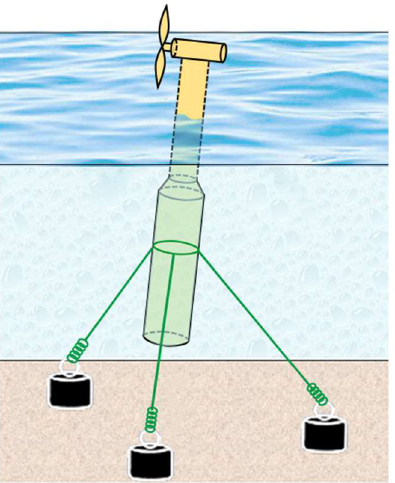
Figure 3. Spar-typed wind turbine with its taut mooring lines. The translational motion and the rotational motion of a rigid body are expressed in the spaced-fixed coordinate system OXYZ with origin at O and the body-fixed coordinate system oxyz with origin at o , respectively. Where ξ is the translational displacement of the body at point o in OXYZ , ω is the rotational velocity in OXYZ ; r g = ( x g , y g , z g ) t ; is the point vector of mass center of the body in OXYZ ; I is the moment of inertia of the body, with respect to point o in OXYZ ; T is a transfer matrix between the oxyz and OXYZ . Given the total external forces (cid:101) F acting on the body in OXYZ and the total external moments with respect to o, M can be unified by F, as shown